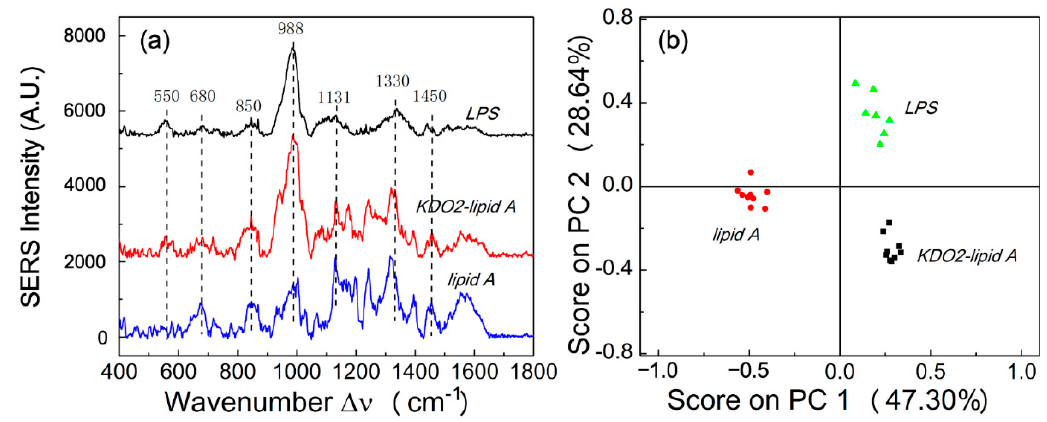
Figure 1. Meningococcal LPS Raman SERS spectra. ( a ) SERS spectra of LPS, KDO 2 -lipid A, and lipid A obtained from Neisseria meningitidis endotoxin structures. ( b ) The PCA score plot of SERS spectra of LPS, KDO 2 -lipid A, and lipid A.